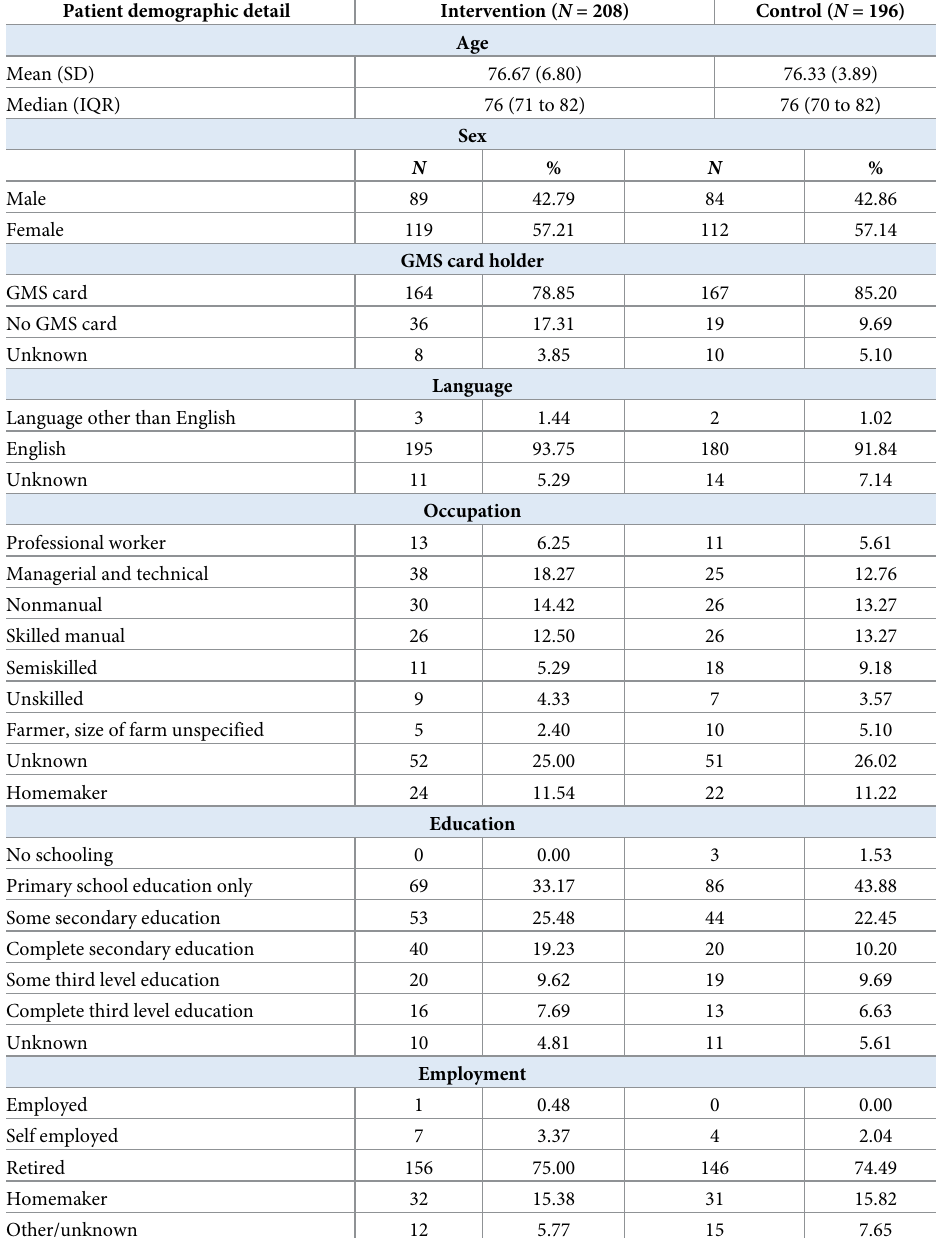
Table 2. Patient demographics in each group at